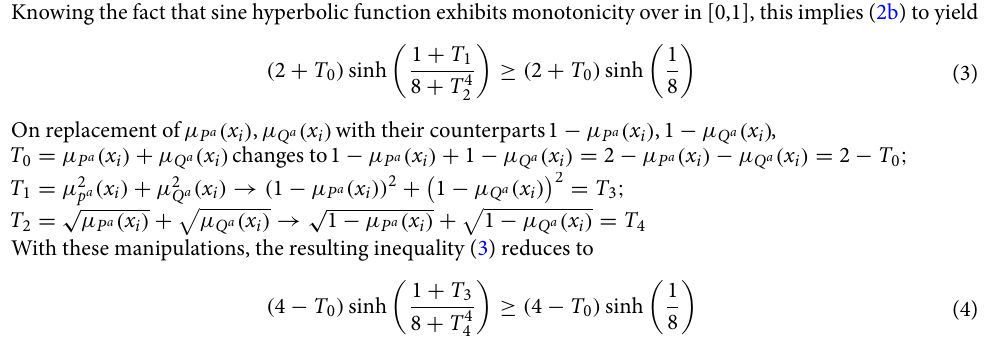
µ , Q a P a CE FS FS (cid:31) (cid:30)